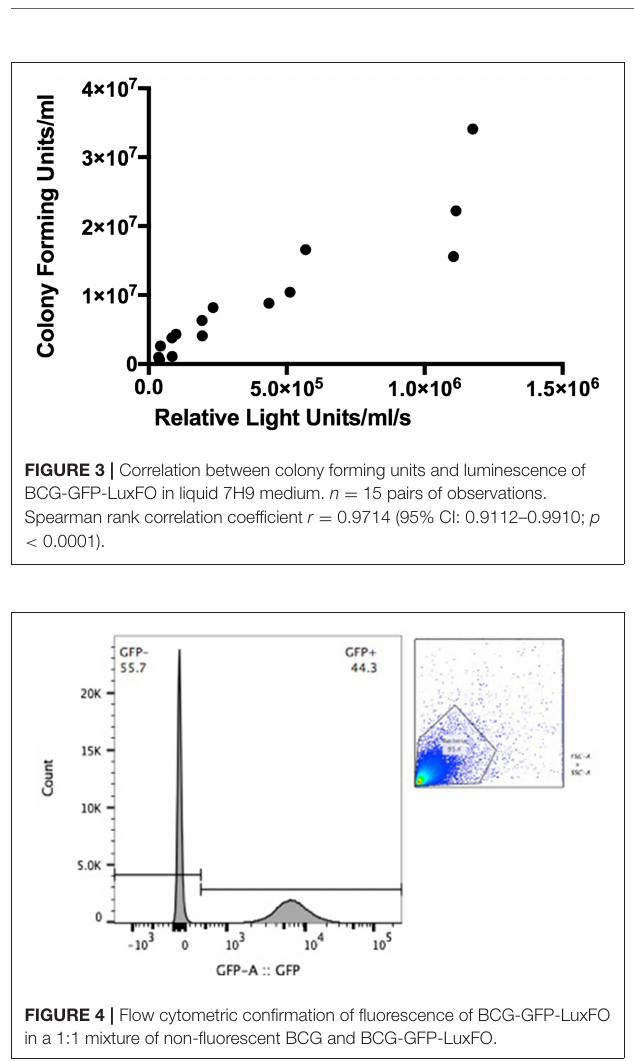
X (Graphpad Software, La Jolla, CA, USA). Two-tailed significance testing was applied with p < 0.05 considered to be statistically significant.